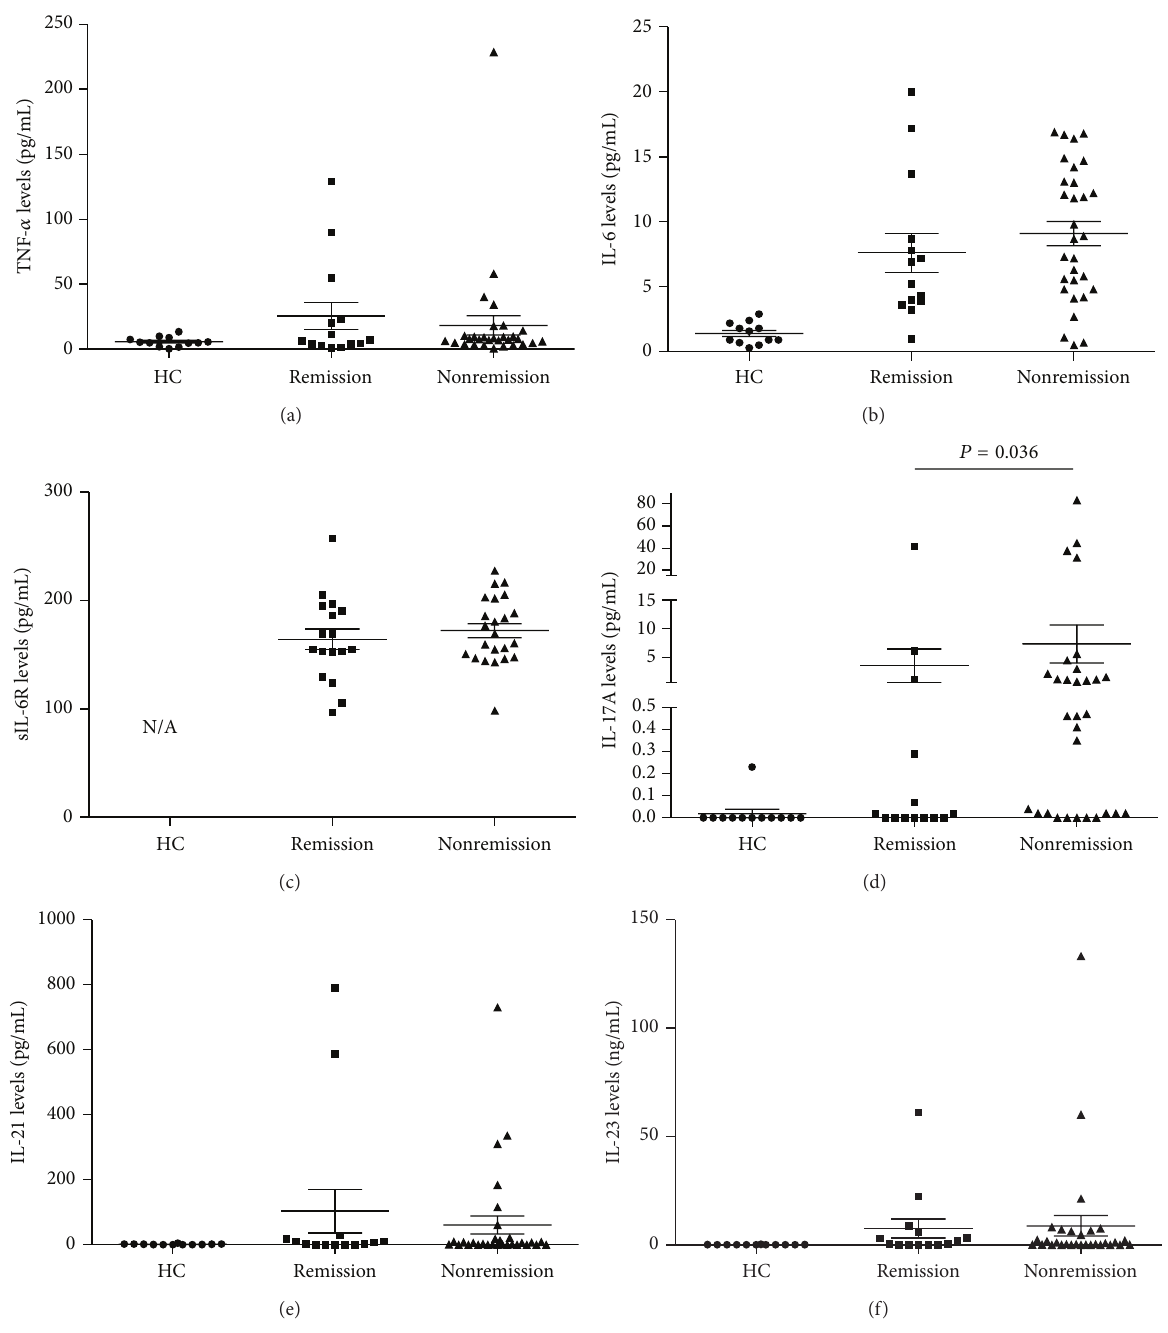
Figure 1: Baseline IL-17A levels are lower in the patients who reached DAS28 ESR remission at 12 weeks of tocilizumab treatment. Baseline serum levels of TNF- 𝛼 (a), IL-6 (b), sIL-6R (c), IL-21 (e), and IL-23 (f) did not differ between the patients with DAS28 ESR remission ( 𝑛 = 14 ) and nonremission ( 𝑛 = 30 ) at 12 weeks of tocilizumab treatment. Only IL-17A levels were significantly lower in the remission patients (d). Of note, sIL-6R levels were not checked in healthy controls. Dot represents each person and bars represent the mean value and SEM. 𝑃 value was assessed by Mann-Whitney U test. HC = healthy controls and N/A = not